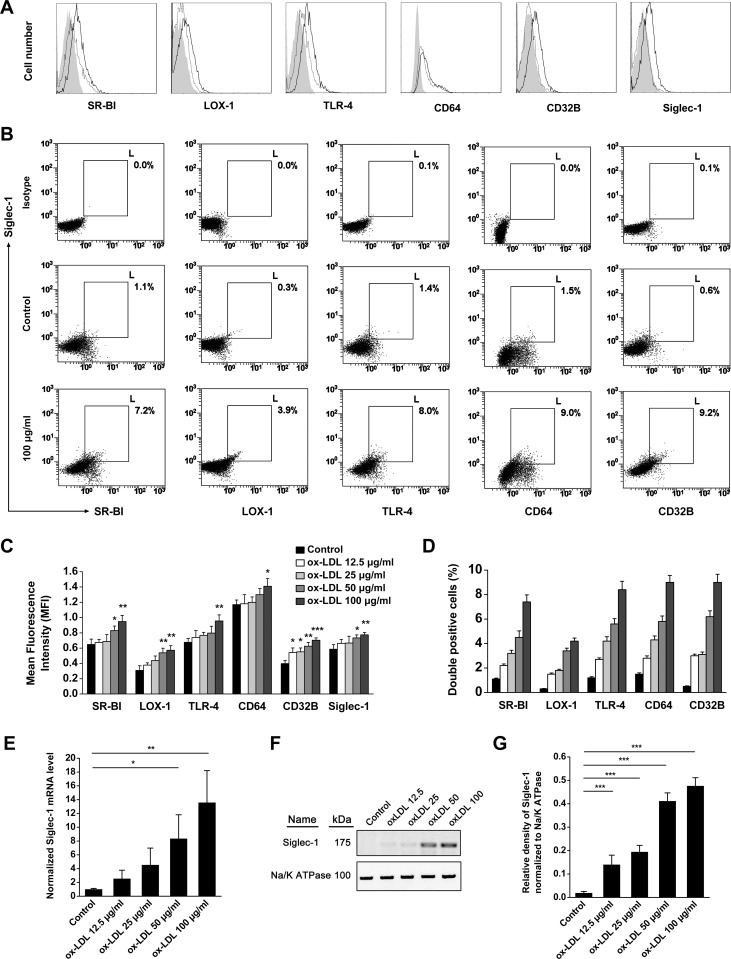
OxLDL can up-regulate many receptors, including Siglec-1.BMMs were stimulated with different concentration of oxLDL (0, 12.5, 25, 50, 100 µg/ml) for 48 h and harvested for FACS, QRT-PCR and Western blot analysis. (A), Single parameter histogram of different receptors expression, abscissa represent cell number and ordinate represent fluorescence intensity. Shadow areas indicate isotype control, dotted lines indicate oxLDL 0 µg/ml and solid lines indicate oxLDL 100 µg/ml. (B), Double-parameter analysis of Siglec-1 and other oxLDL receptors. (C), Statistical analysis of panel A (n = 6). oxLDL can stimulate these receptors expression in a dose-dependent manner. *p<0.05,**p<0.01,***p<0.001 vs. their own control groups. (D), Statistical analysis of panel B, legend as in panel C, all treatment groups have p values <0.001 vs. their own control groups (n = 6). (E), QRT-PCR detection of Siglec-1 expression by the stimulation of different concentrations of oxLDL. *p<0.05,**p<0.01. (F–G), Western blot detection of Siglec-1 expression by oxLDL stimulation. ***p<0.001.